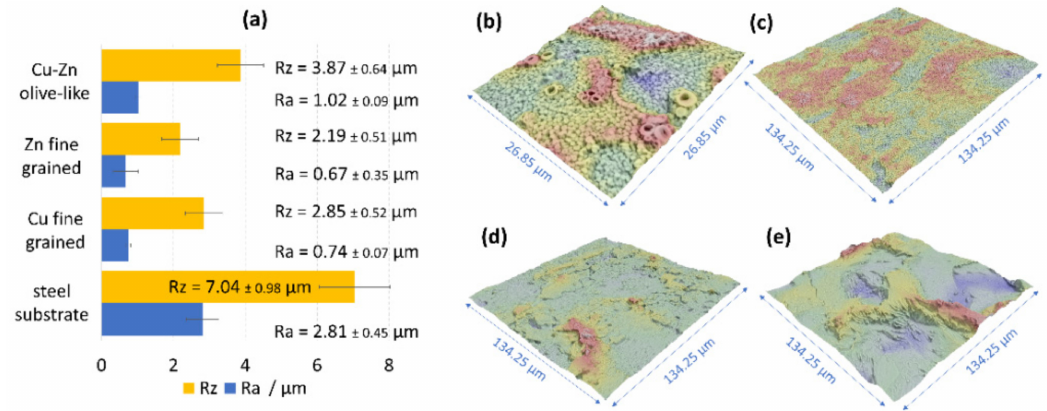
Figure 14. Roughness results ( a ) obtained on the basis of the 3D surface reconstructions of: ( b ) brass coating of the olive-like structure; ( c ) fine-grained copper coating; ( d ) fine-grained zinc coating; ( e ) etched steel